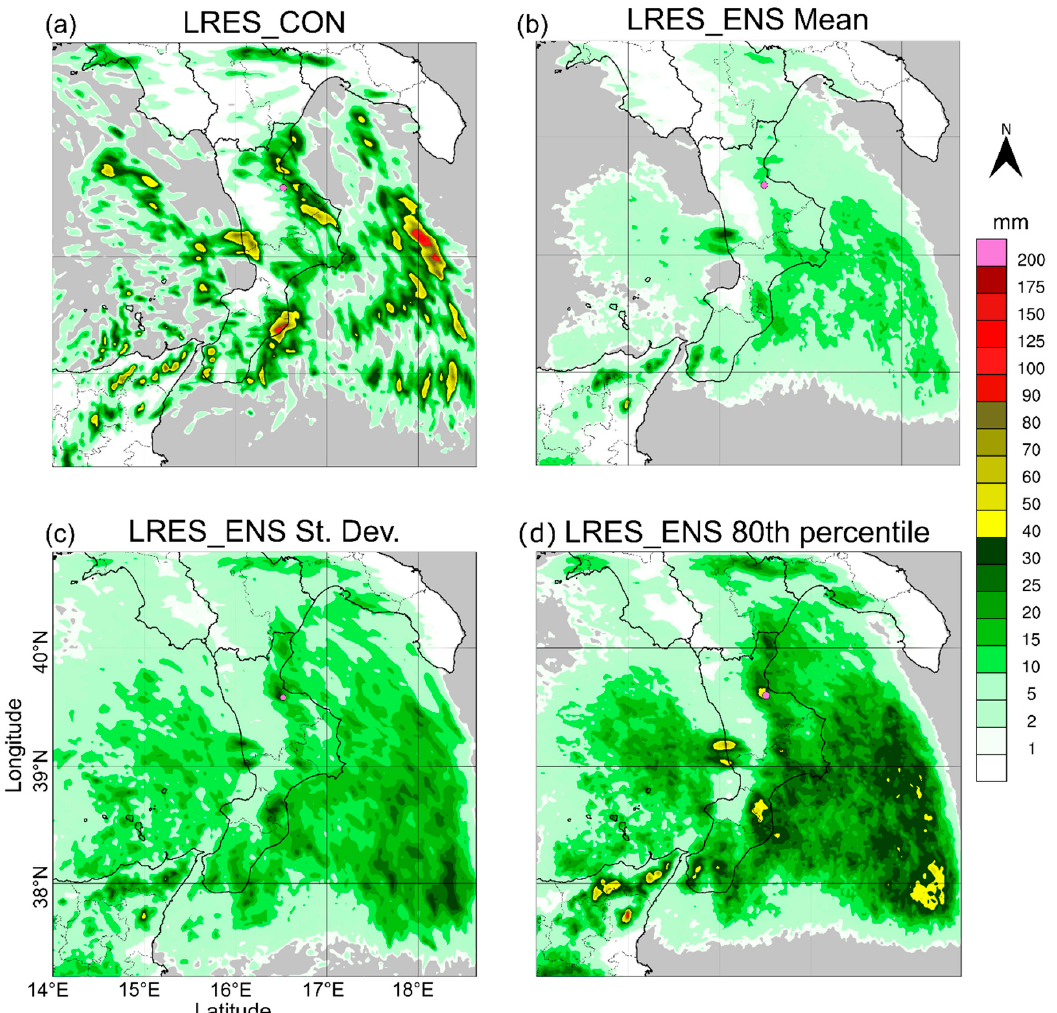
Figure 3. Accumulated precipitation (mm) simulated by WRF using the ECMWF EPS boundary conditions (simulation start at 0000 UTC, 11 August 2015) during the 24-h-long period 1800 UTC, 11 August 2015—1800 UTC, 12 August 2015: ( a ) low-resolution control simulation; ( b ) cell-by-cell mean of the 50 perturbed forecasts, ( c ) same as ( b ), but for standard deviation; ( d ) same as ( b ), but for the 80th percentile. The colored dot represents the Corigliano gauge station.